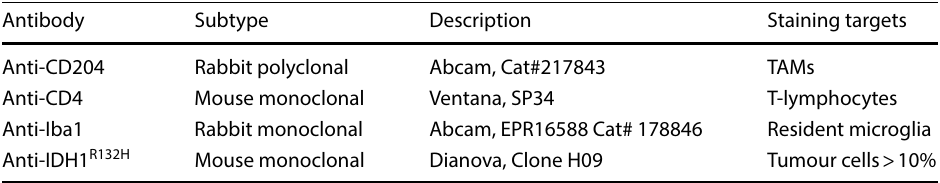
antibodies used in this